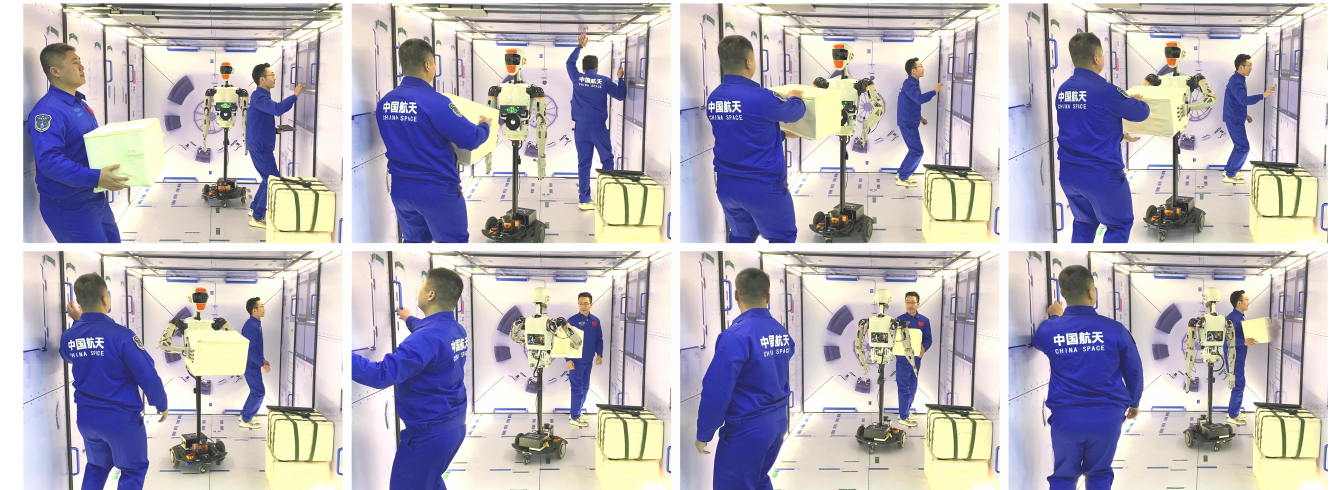
Figure 13. Taikobot works along with several astronauts and helps transport large